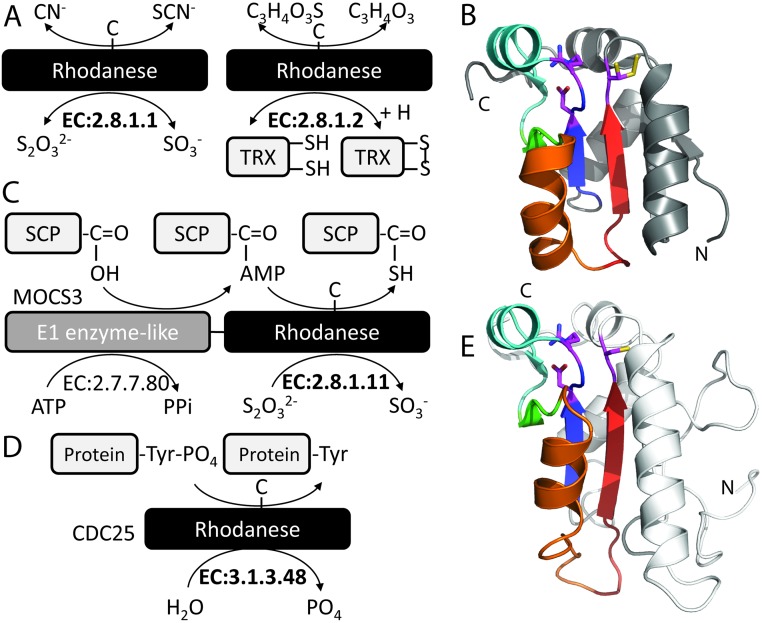
Heterogeneous reactions catalyzed by the Rhodanese F-group (EC numbers in bold) through Cys residue intermediates: (A) Rhodanese reactions transfer sulfur groups from thiosulfate to cyanide (EC: 2.8.1.1) or from mercaptopyruvate to oxidize thioredoxin (EC: 2.8.1.2). (B) GlpE rhodanese domain from PDB: 1GMX (gray cartoon) with RLM (rainbow) and active site with an additional conserved motif (magenta stick). (C) Sulfur group transfer to the C-terminal ampylated Gly residue of sulfur carrier protein (SCP) in a bi-functional MOCS3 (Molybdenum Cofactor Synthesis 3) enzyme (EC: 2.8.1.11 and EC: 2.7.7.80). (D) CDC25 phosphate hydrolysis from protein Phospho-Tyr residue (EC: 3.1.3.48). (E) CDC25 phosphatase rhodanese-like domain from PDB: 1QB0 with RLM domain (rainbow) retains similar active site (magenta stick). (B, E) Note that the β-strand (β2; green) can be considered as being barely existent (or vestigial) among the universe of RLMs being considered in this work.